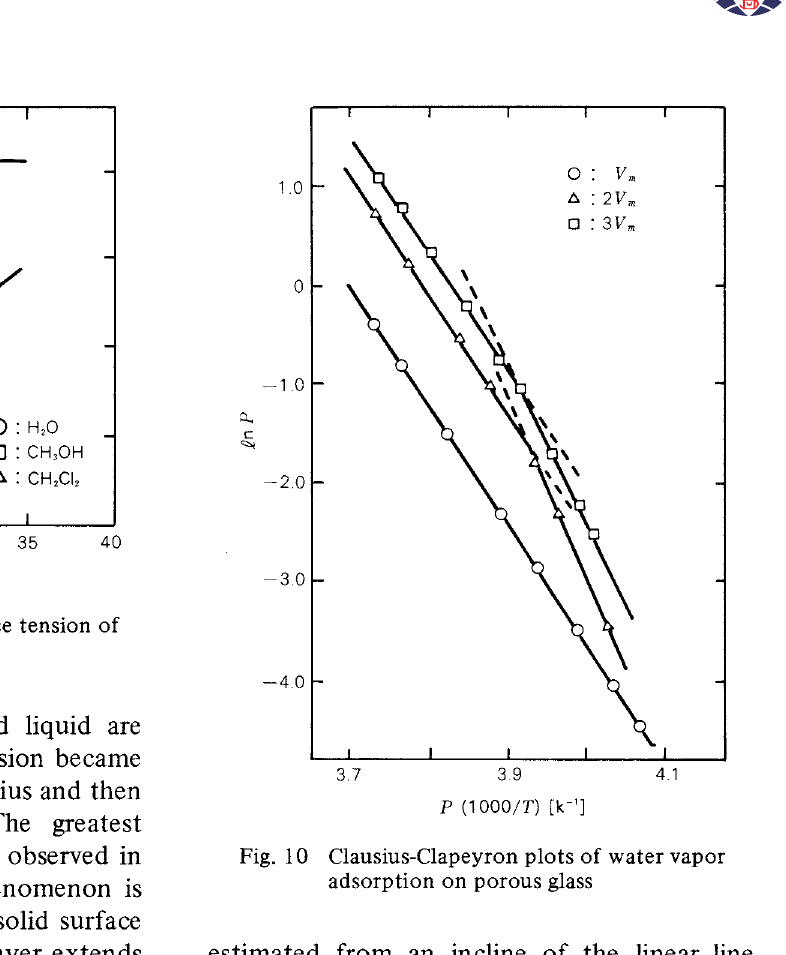
Fig. 10 Clausius-Clapeyron plots of water vapor adsorption on porous glass estimated from an incline of the linear